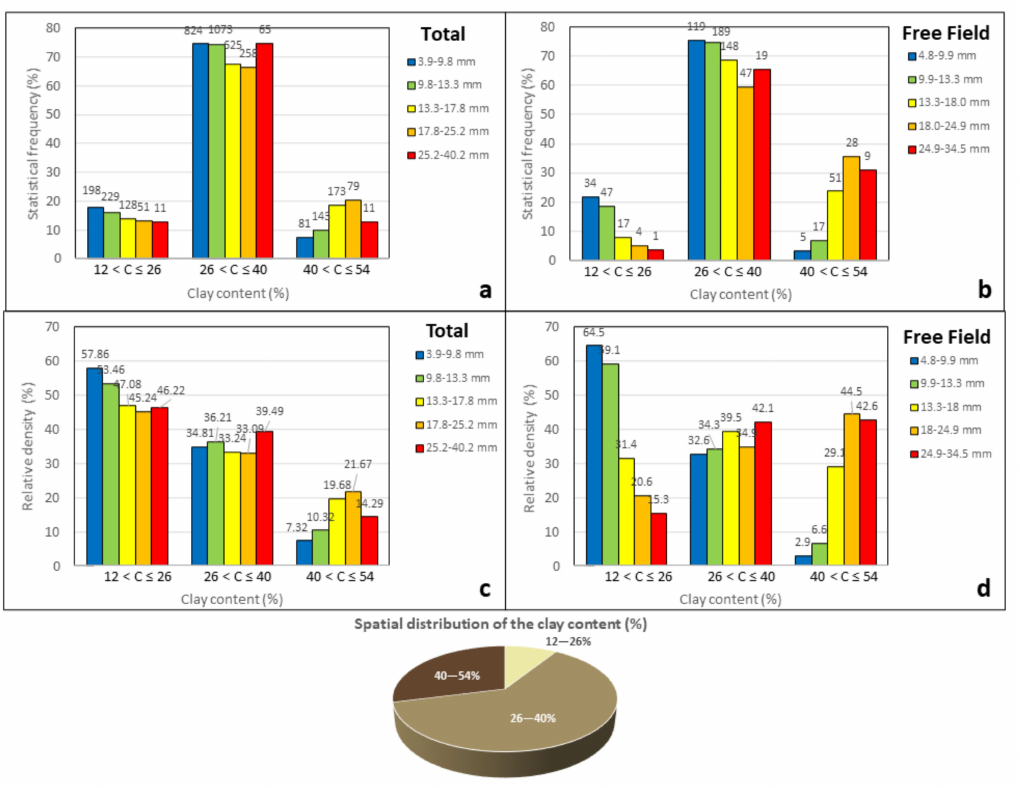
Figure 9. Statistical frequency ( a , b ) and relative density ( c , d ) of the vertical displacement amplitude points as a function of the khaki marl clay content for total and free field PS points.